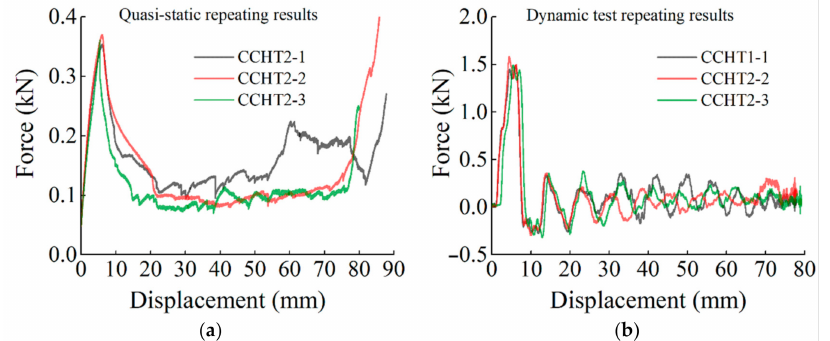
Figure 4. Three-times repeated force–displacement curves of the samples under quasi-static and dynamic compressive loading conditions: ( a ) CCHT2 under a quasi-static loading speed of 1 mm/min and ( b ) CCHT1 under a dynamic loading speed of 5 m/s − 1